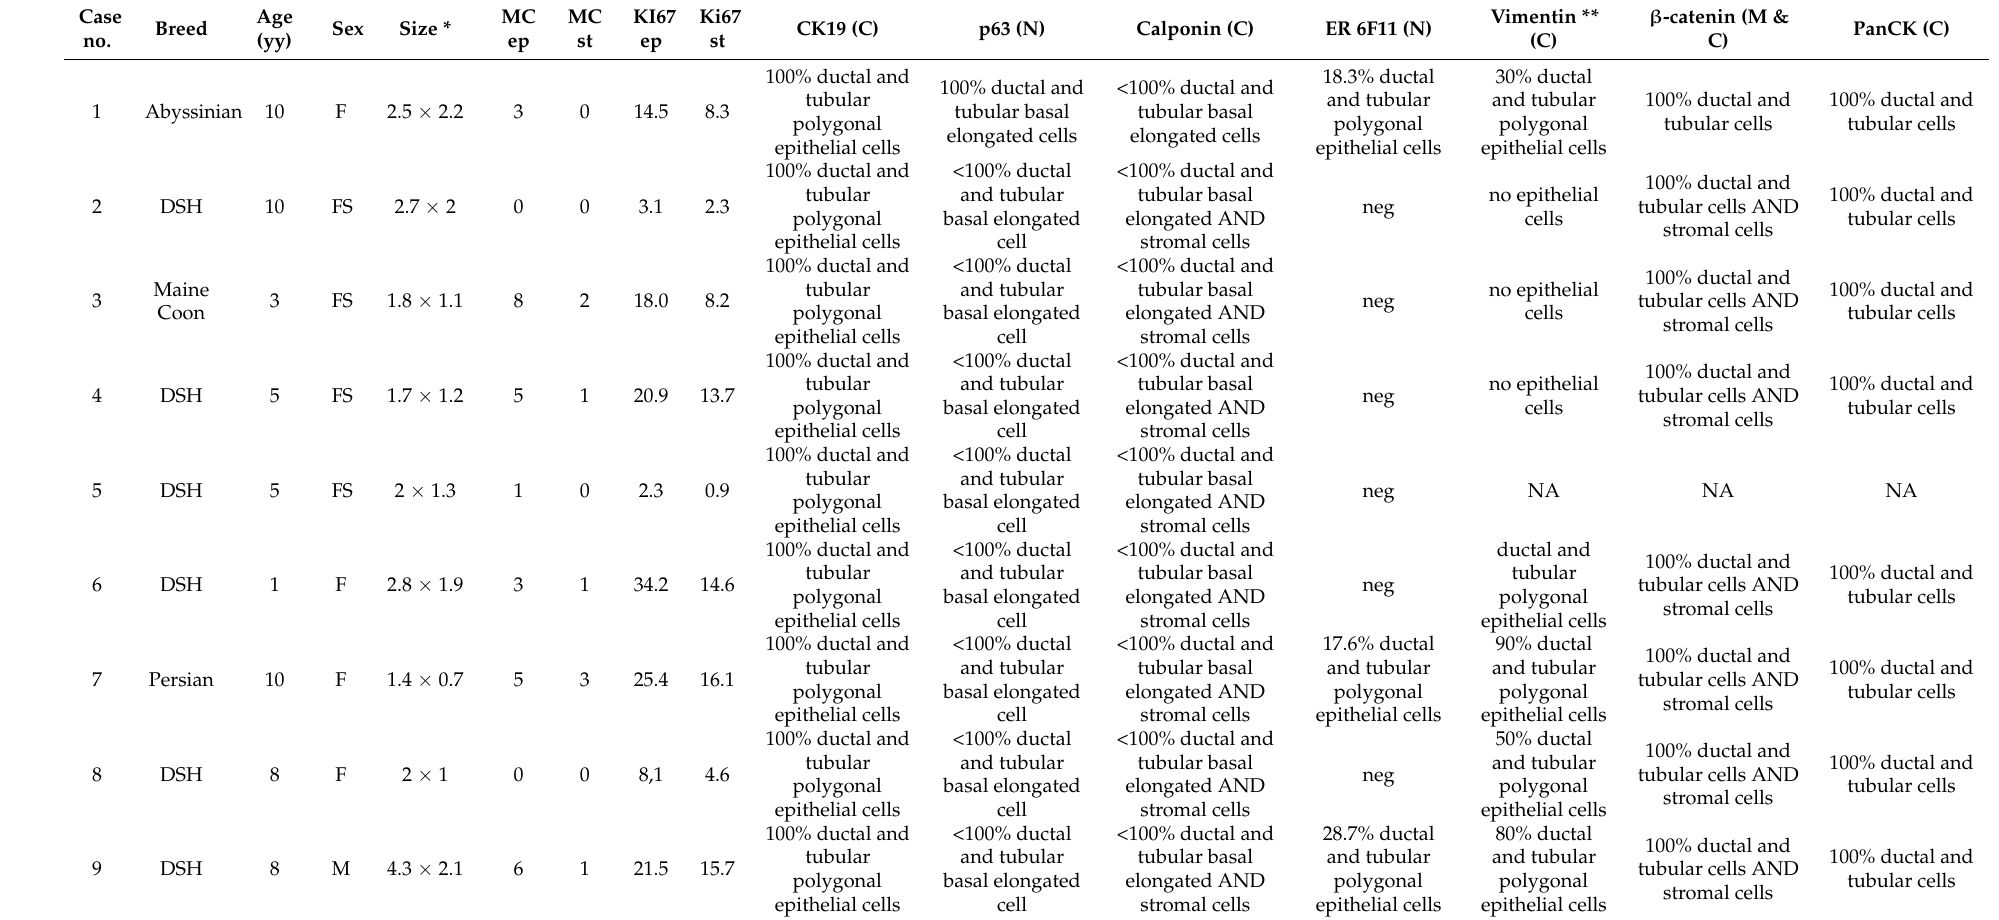
Table 2. Cases included in the study: clinical, morphological, and immunohistochemical features. Case